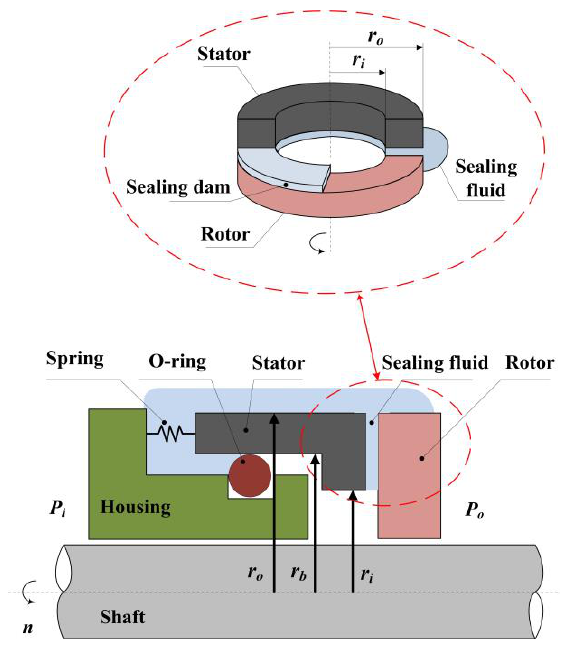
Figure 1. Schematic of a mechanical face seal.